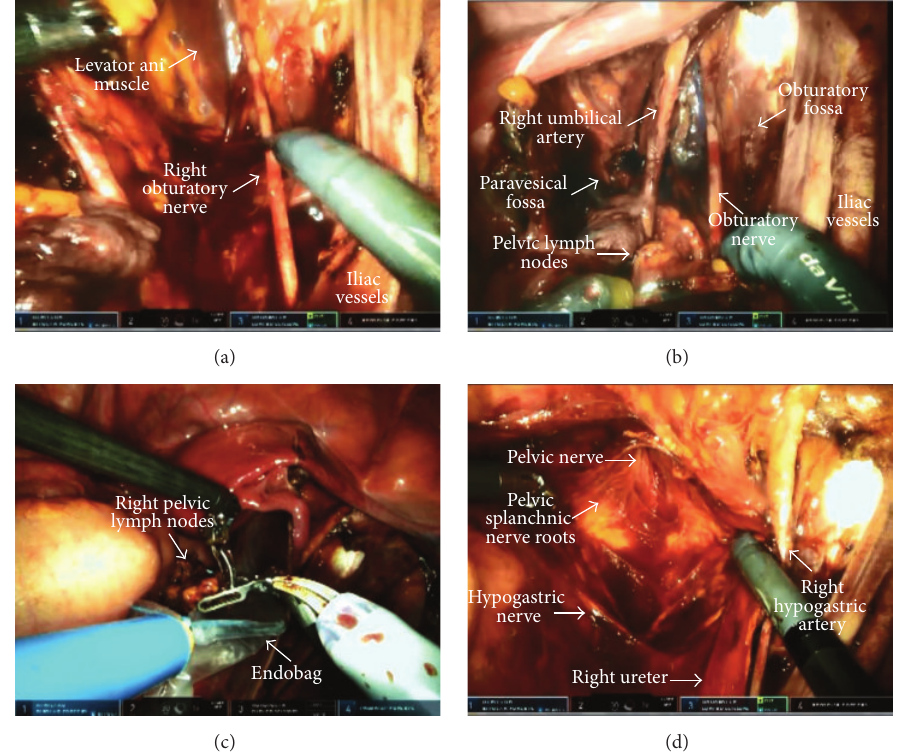
Figure 1: Therapeutic pelvic lymphadenectomy (right side). (a, b) The view of the right pelvic side wall after lymph node dissection. (c) Placing the dissected lymph nodes into Endobag (cid:3) . (d) The view of the hypogastric nerve, pelvic splanchnic nerve roots, and pelvic nerve following the dissection of the medial pararectal